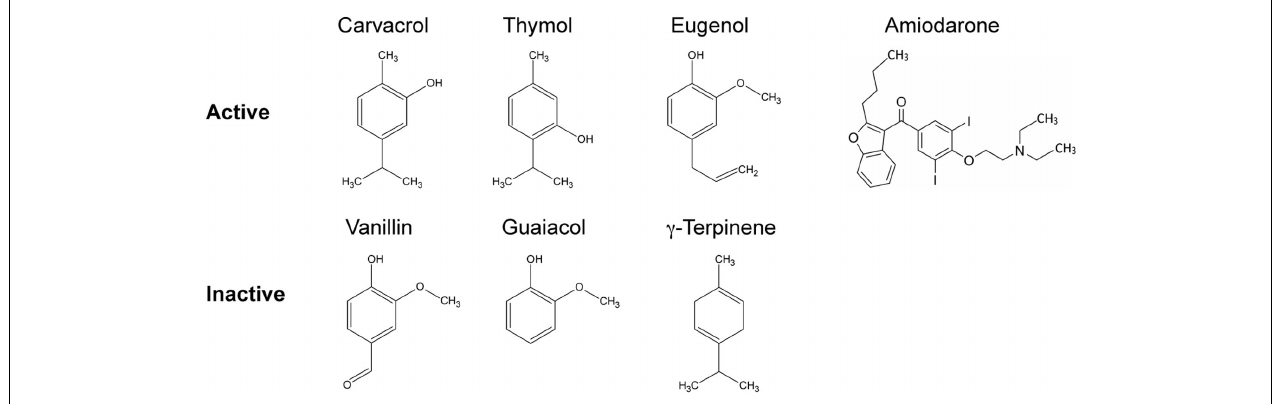
FIGURE 1 | Structures of terpenoid phenols found in plant essential oils, with closely related precursors. A subset of these compounds elicit Ca 2 + and pH transients and are active as antifungals. Compounds with MIC greater